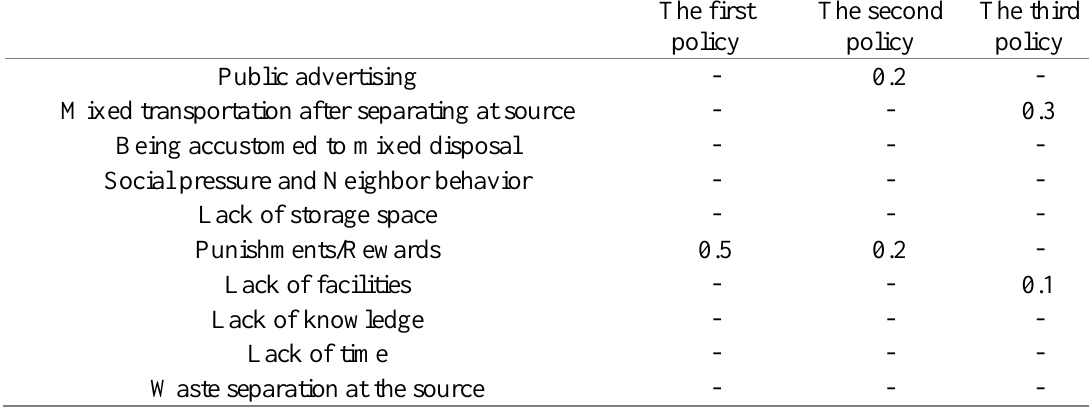
Table 3. The change percentage in variables with direct municipality manipulating